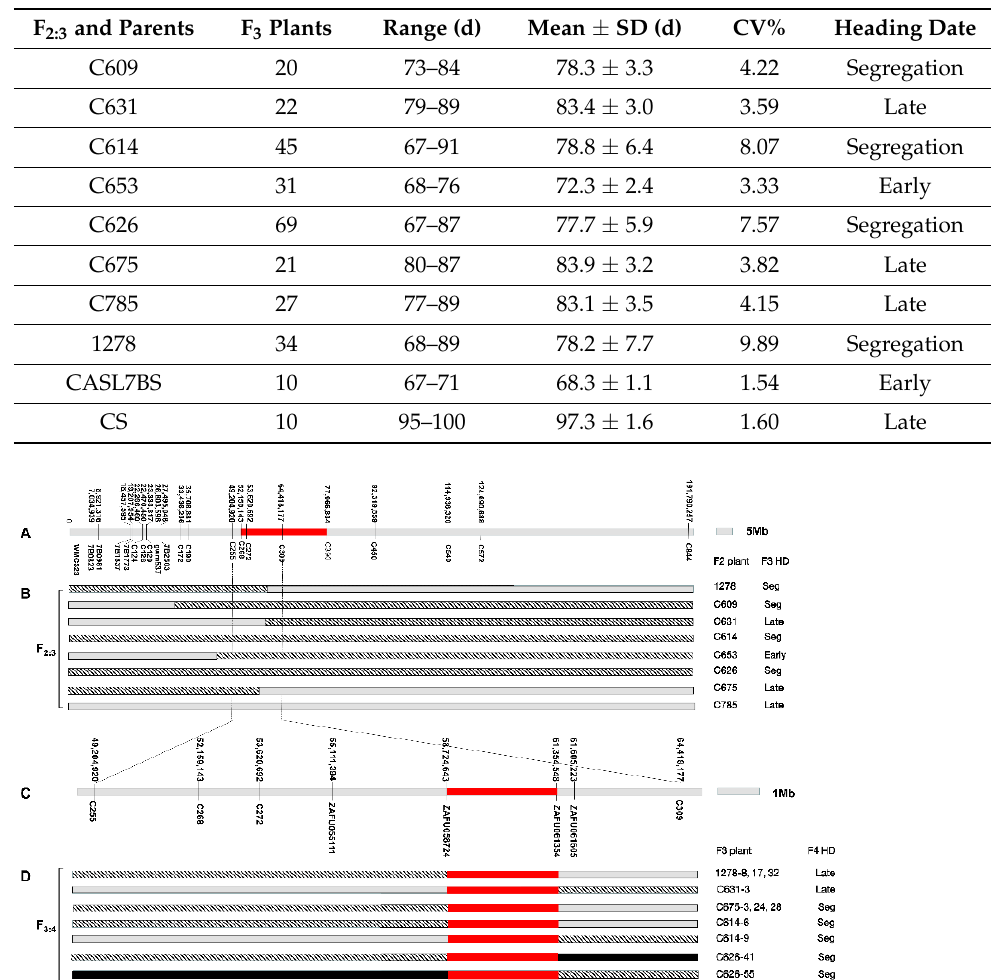
Figure 9. Fine mapping of the QTL related to heading date using (CS × CASL7BS) F 2:3 and F 3:4 families. ( A ): Physical map correspondence to the genetic map of Figure 8c, Region highlighted with red corresponded to the QTL region of the genetic map. ( B ): Constitute of the chromosome segment corresponding to that from WMC323 to C844 in genetic map in some F 2 plants. ( C ): Physical map of the region around the QTL mapped by using F 2 data. Four new indel markers with prefix of ZAFU were added in this map. ( D ): Constitute of the chromosome segment in some F 3 plants. The segment highlighted with red is the locations of HD-related QTL, which were determined by genotype of SSR/indel markers and HDs. Grey bars represented the CS chromosome segments, black TTD chromosome segments, and bars with strip lines heterozygote ones. “Later” means that the F 2:3 or F 3:4 families have the similar HD as CS on average, “Early” means that the F 2:3 or F 3:4 families have the similar HD as CASL7BS on average. “Seg” means that the plants in F 2:3 or F 3:4 families segregated for HD.